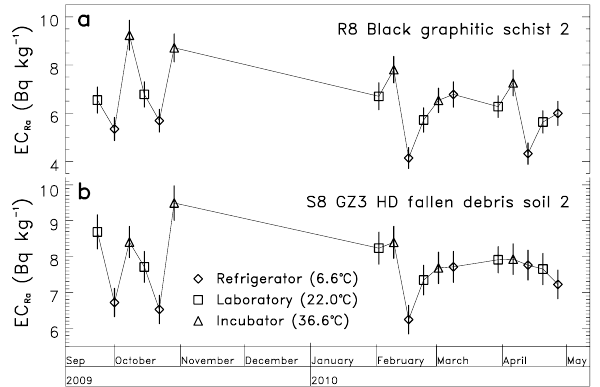
Fig. 2. EC Ra measurements versus time for two samples: one rock sample, R8 (a) , and one soil sample, S8 (b) . The symbols represent the temperature conditions for the measurement: in refrigerator (diamonds), in laboratory (squares) and in incubator (triangles). Error bars are at ± 1 σ , corresponding to a confidence level of